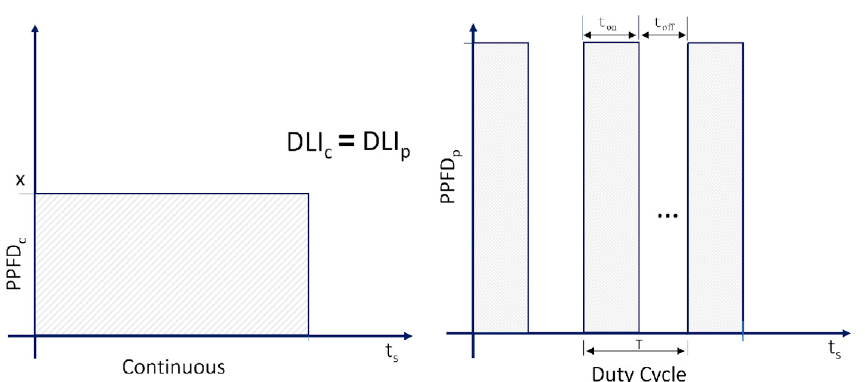
Figure 3. Graphic representation of the energy equivalence supplied to the plant under the operation modes: continuous ( left ) and pulsed LED light ( right ).